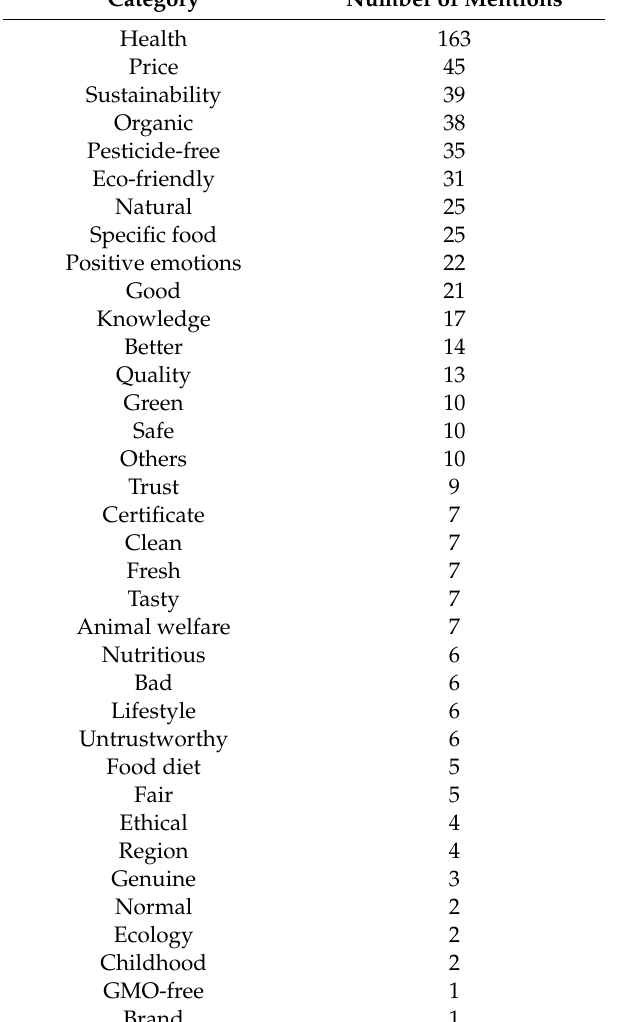
Table A1. Frequency of mention of the 36 categories of organic food-related wellbeing and the most salient individual words when participants were asked to write down the first three words that come to their mind when thinking about organic food and subjective